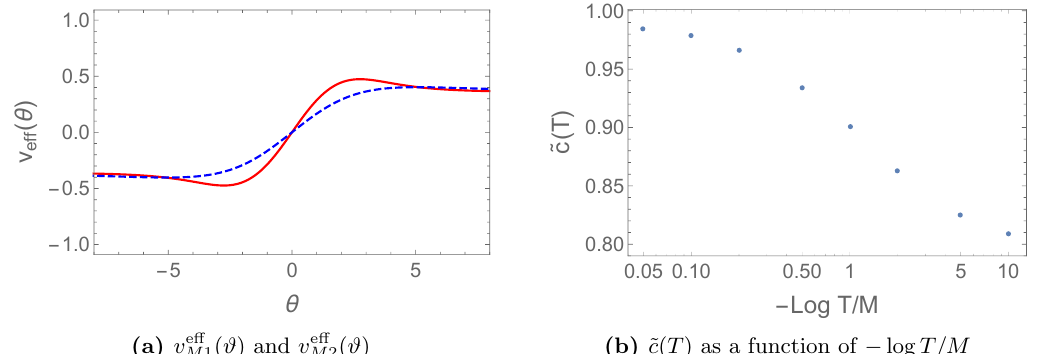
Figure 3. (a) the e(cid:11)ective velocities of the (cid:12)rst (red continuous curve) and second (blue dashed curve) magnons in the D 4 (cid:13)ow in a thermal state with T=M = 1 : 4. The (cid:12)rst and the second magnons correspond to the (cid:12)rst and second nodes in the D 4 Dynkin diagram. (b) The c-theorem for the D 4 massless model. The c function interpolates between the UV and IR central charges e whose values are 1 and